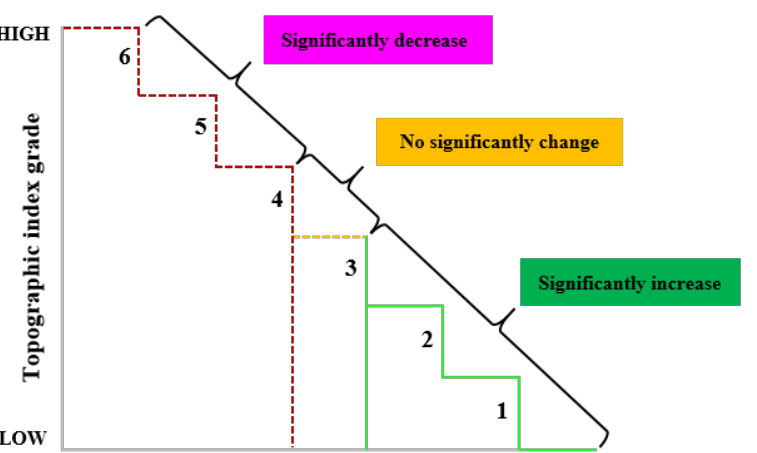
Figure 12. Proportion of habitat quality decreases for different topographic positions.